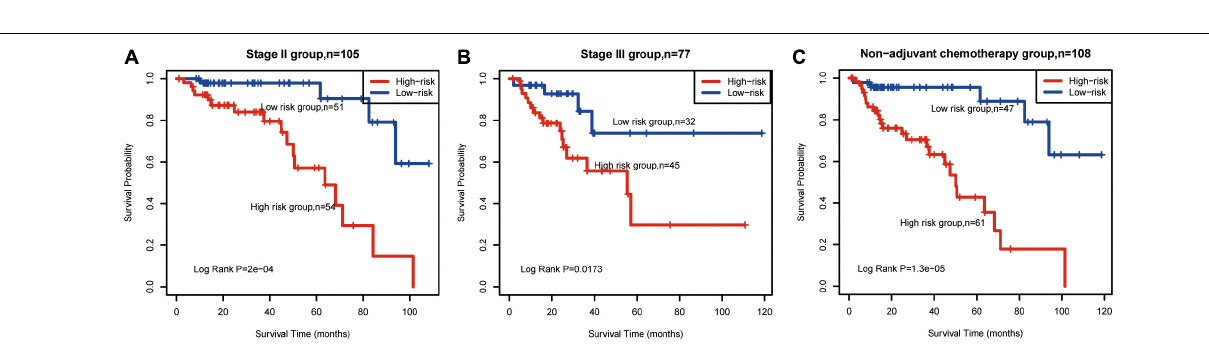
FIGURE 3 | Survival prediction in patients with CRC subtypes. Kaplan–Meier survival curves classified patients into high- and low-risk groups using the methylated signature. (A) Stage II group ( n = 105). (B) Stage III group ( n = 77). (C) , non-adjuvant chemotherapy ( n = 108). Vertical hash marks indicate censored data. CRC: colorectal